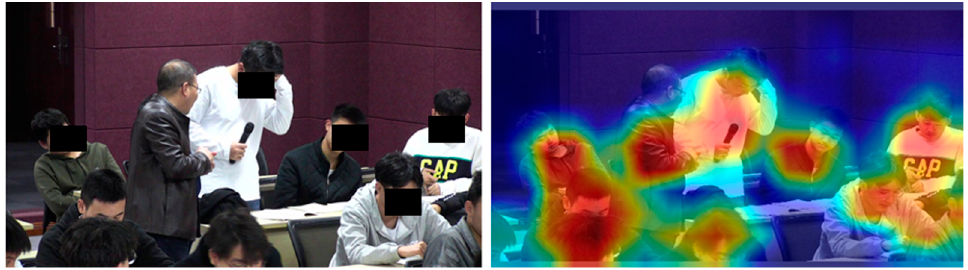
Figure 10. Feature visualization after adding attention mechanism.